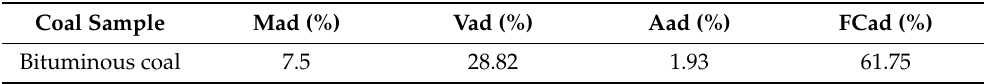
Table 1. Industrial analysis of coal